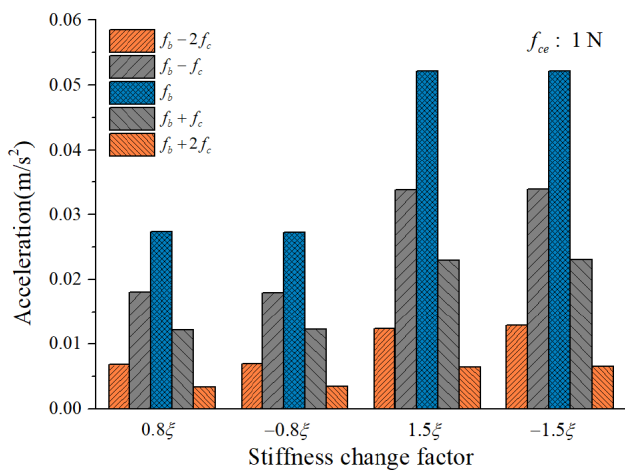
Figure 15. Envelope spectrum peak value at sideband modulation family.